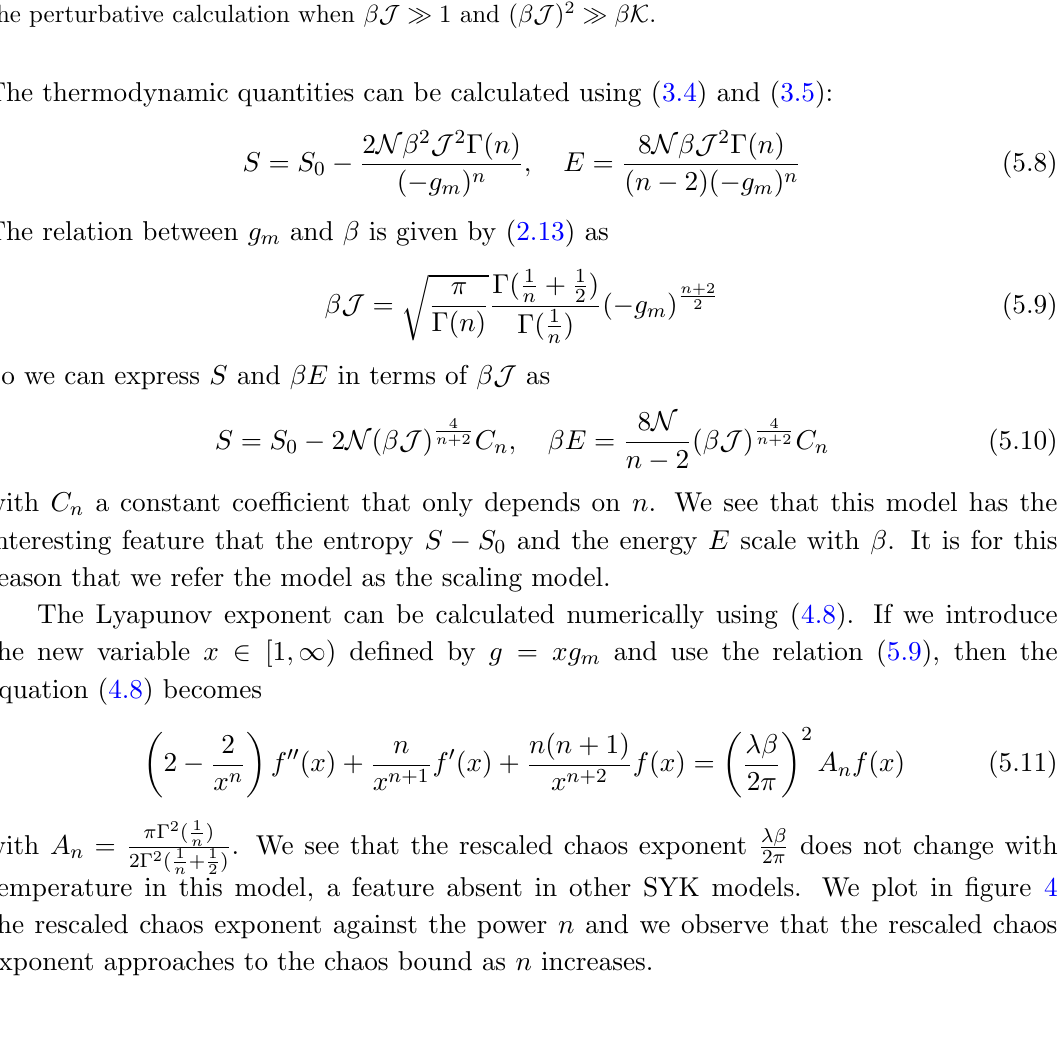
Figure 3 . The (cid:12)gure shows the log plot of the Lyapunov exponent against (cid:12) for the large q and 2 q model with J = 1 and K = 100. The red (dotted) curve shows the result from the perturbative calculation when (cid:12) K (cid:29) 1 and ( (cid:12) J ) 2 (cid:28) (cid:12) K , while the green (dashed) curve shows the result